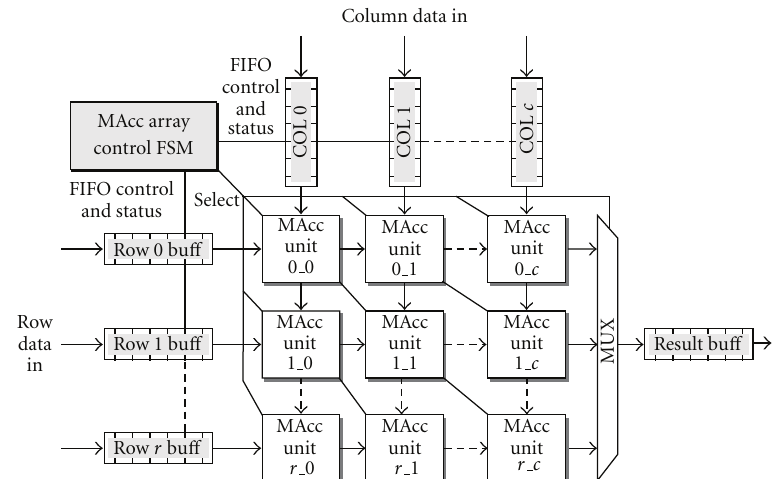
Figure 13: A variable sized array of MAcc units.